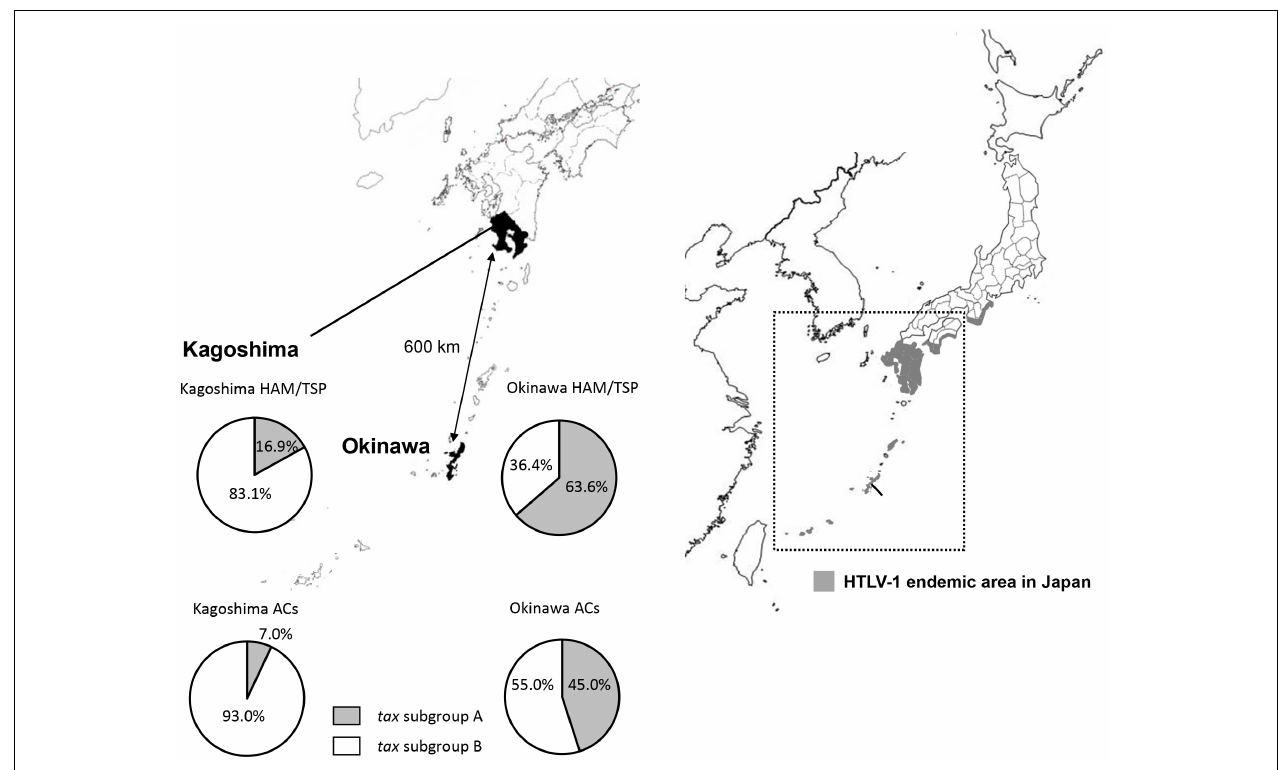
FIGURE 1 | Geographical distribution of HTLV-1 tax subgroups in Kagoshima and Okinawa Prefecture, Japan. The distribution of HTLV-1 tax subgroups varied by geographic region in southern Japan. A significantly higher prevalence of tax subgroup-A was found in Okinawa prefecture than Kagoshima prefecture both in HAM/TSP patients and asymptomatic carriers (ACs) (Okinawa vs. Kagoshima, HAM/TSP: 63.6 vs. 16.9%, p < 0.001, ACs: 45.0 vs. 7.0%, p < 0.001, p -value assessed by χ 2